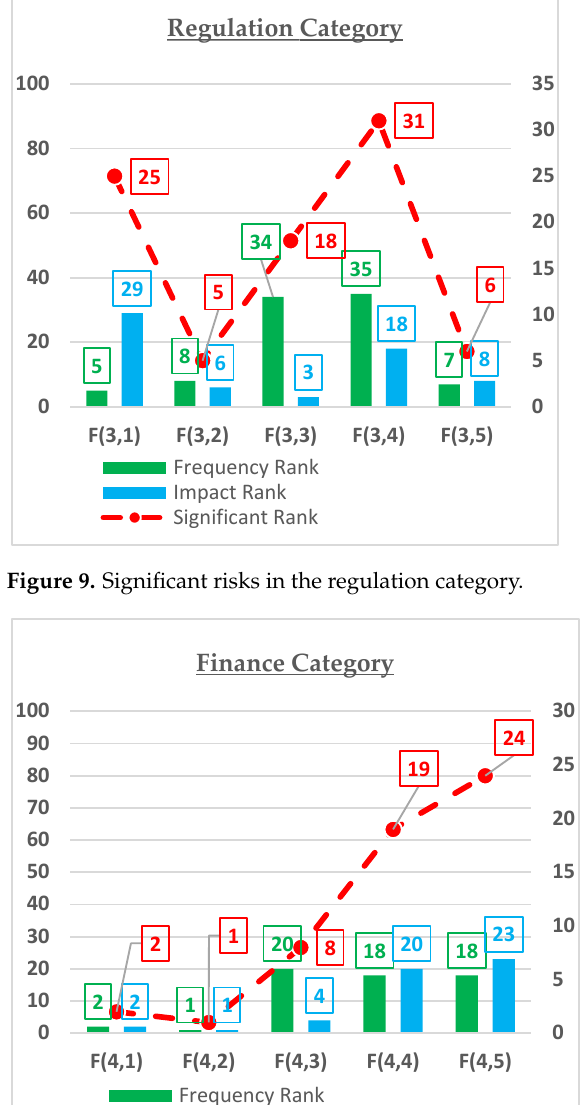
Figure 8. Significant risks in the execution category.